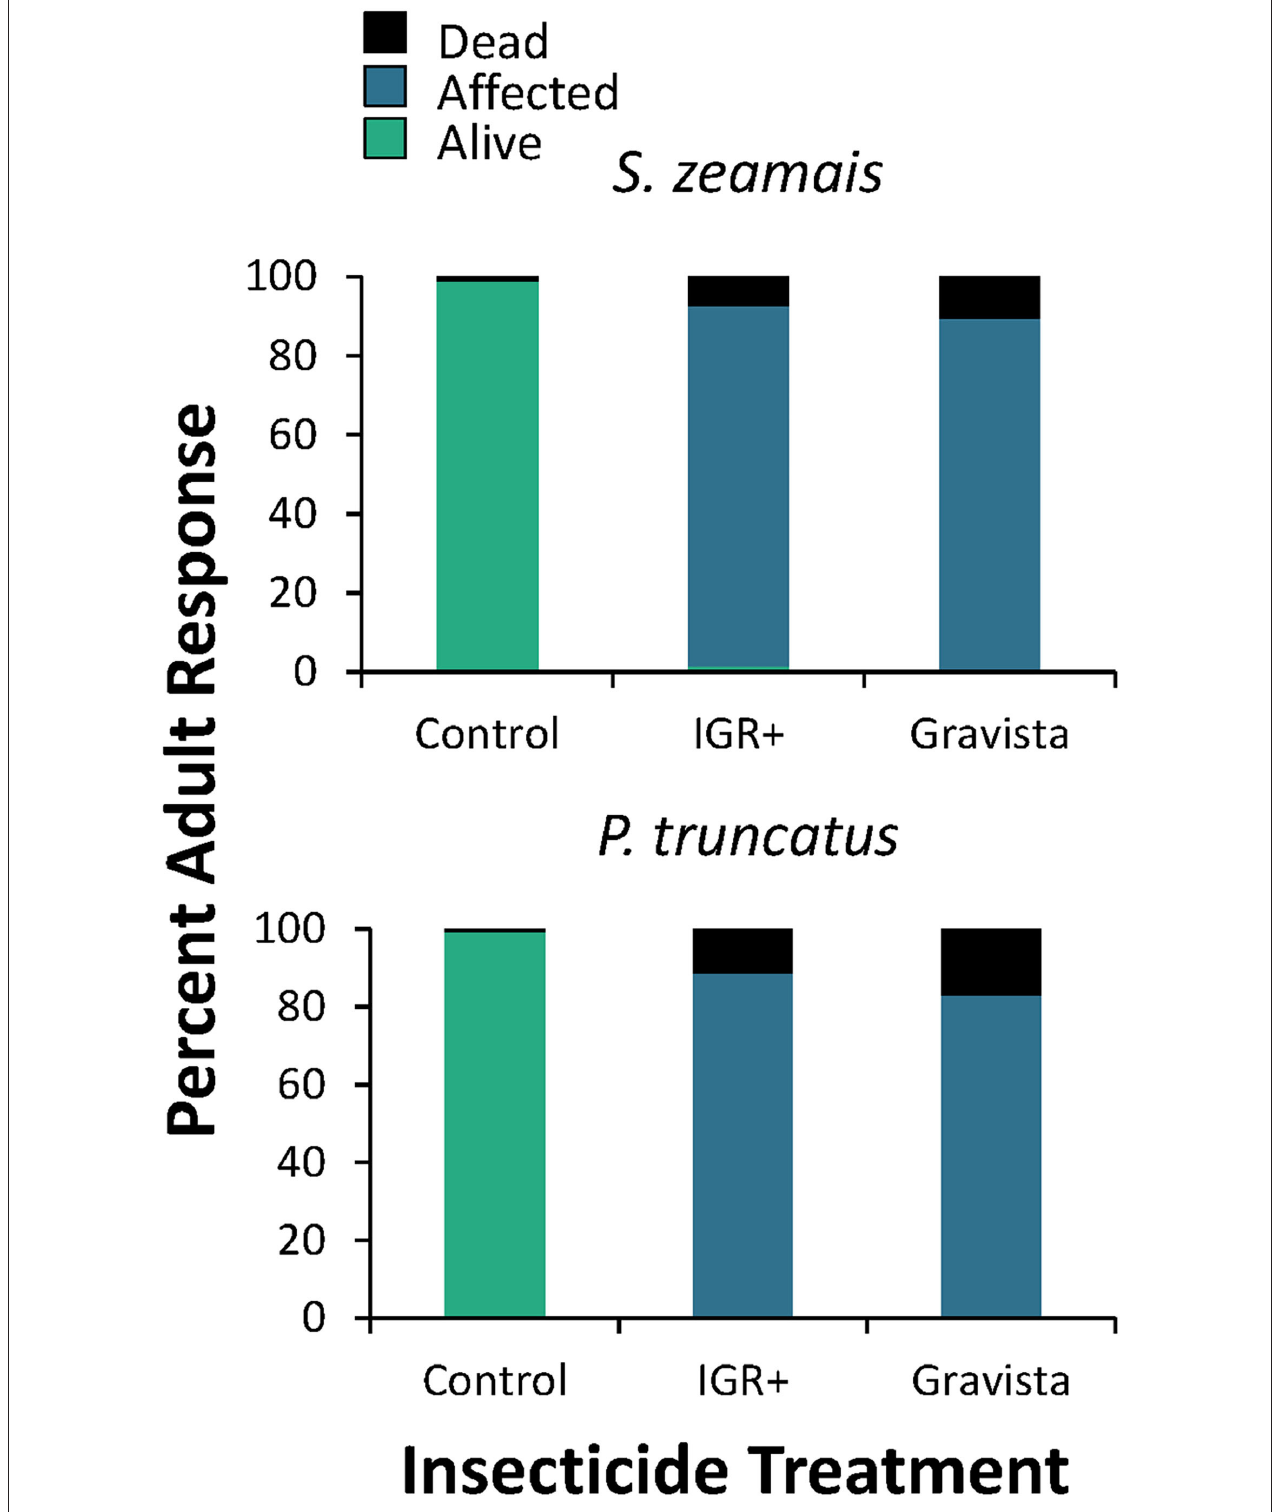
FIGURE 5 | Overall percent mortality induced by an existing (methoprene + deltamethrin, IGR + ) and novel (methoprene + deltamethrin + synergist, Gravista) commercial formulation of insecticide when applied against S. zeamais (top panel) and P. truncatus (bottom panel) as a grain protectant on maize after exposure for 4–168h, resulting in alive (green), affected (blue), or dead (black) individuals.